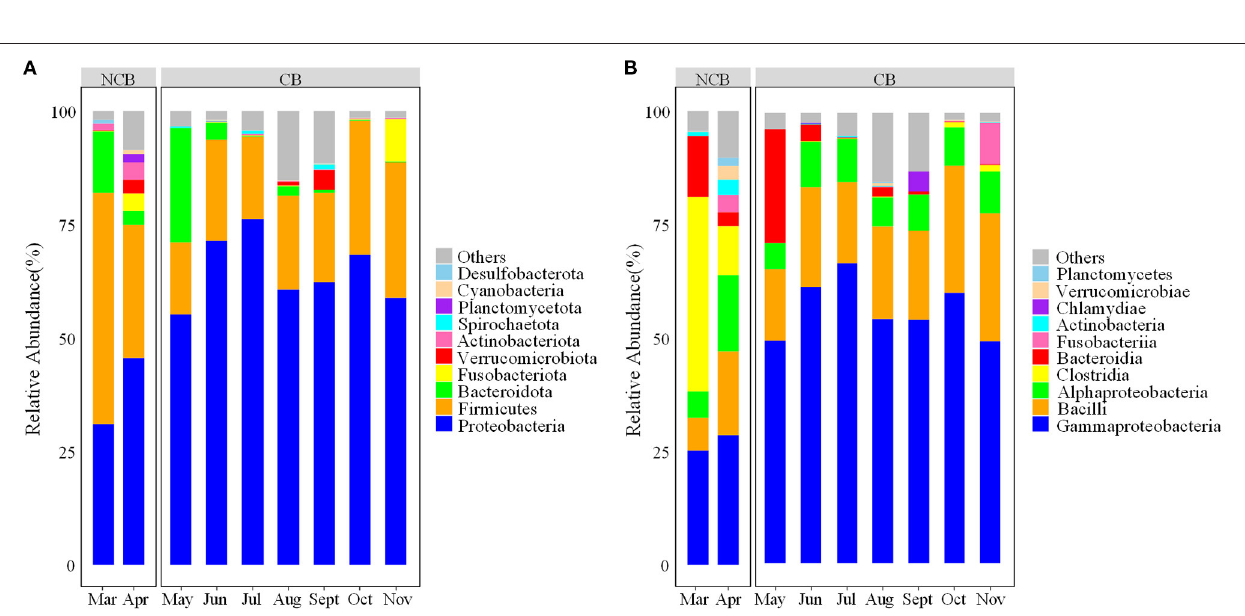
FIGURE 1 | Composition of the bacterial community in the gut of B. aeruginosa snails (A) at the phylum level; (B) at the class level. NCB, non-cyanobacterial bloom; CB, cyanobacterial bloom.